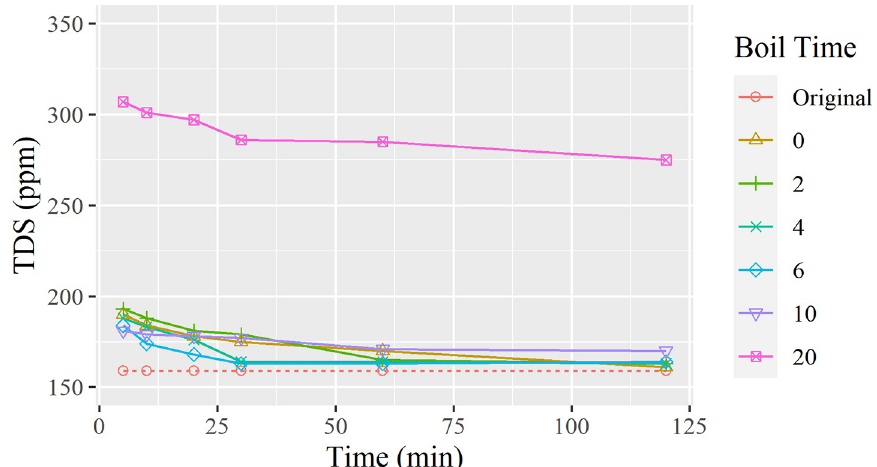
Fig 6. TDS change overtime organized by corresponding boiling durations.